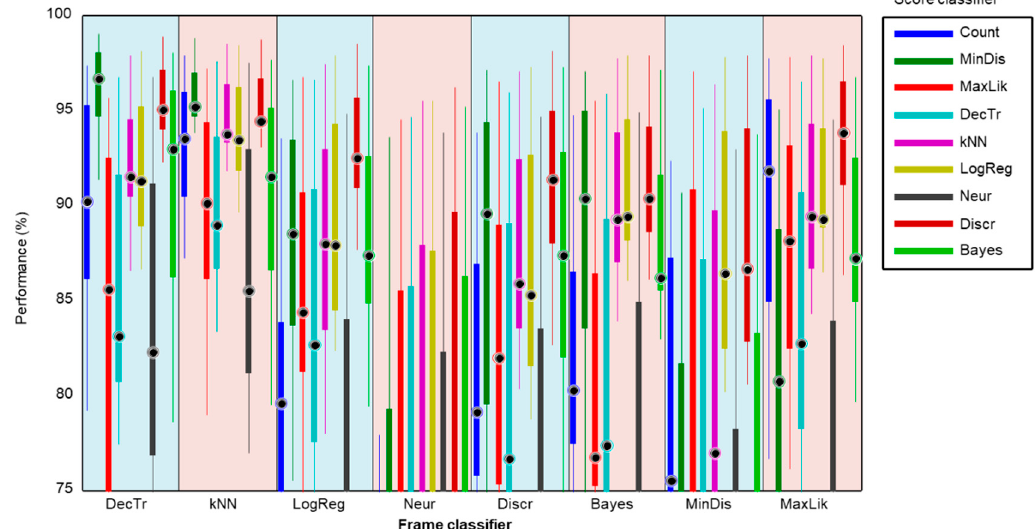
Figure 19. Boxplot (detail) of the performance metrics for the different score-series classifiers operating on the results obtained by every frame classifier.